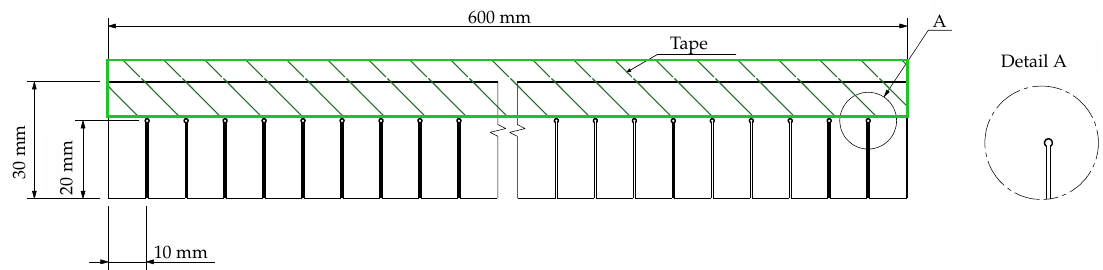
Figure 3. Sketch of the elastic flap dimensions; Detail A is a close-up of the cut between the flaps, and shows the notch that prevents cut spreading due to the shear